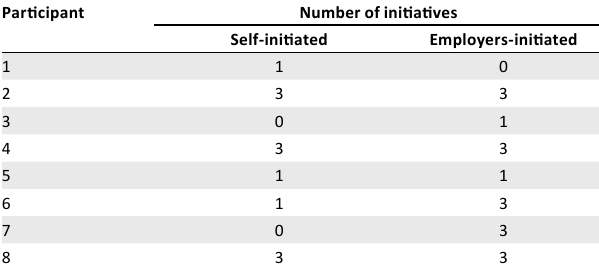
TABLE 1: Training and development